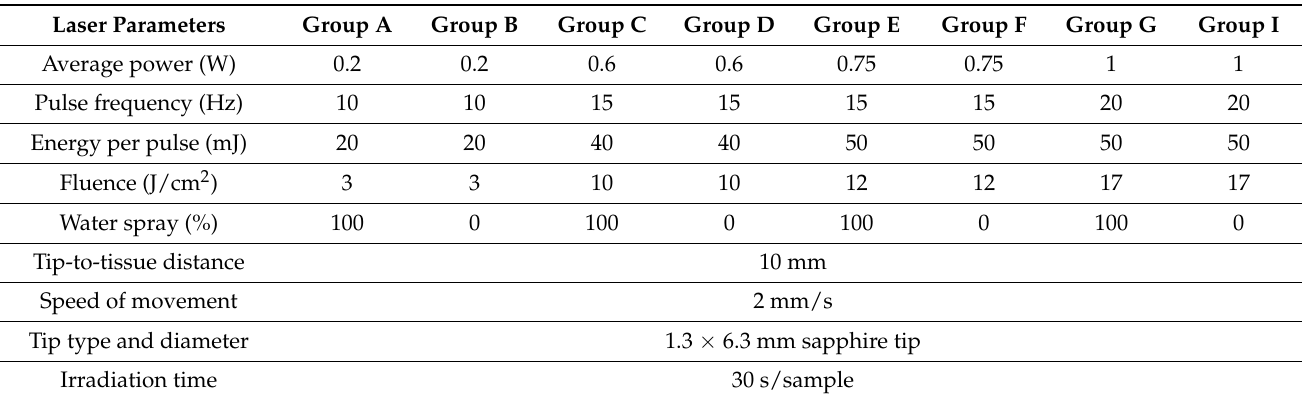
Table 1. The distribution of the pre-emptive pulp laser analgesia (PPLA) parameters according to the experimental group of the study treatment